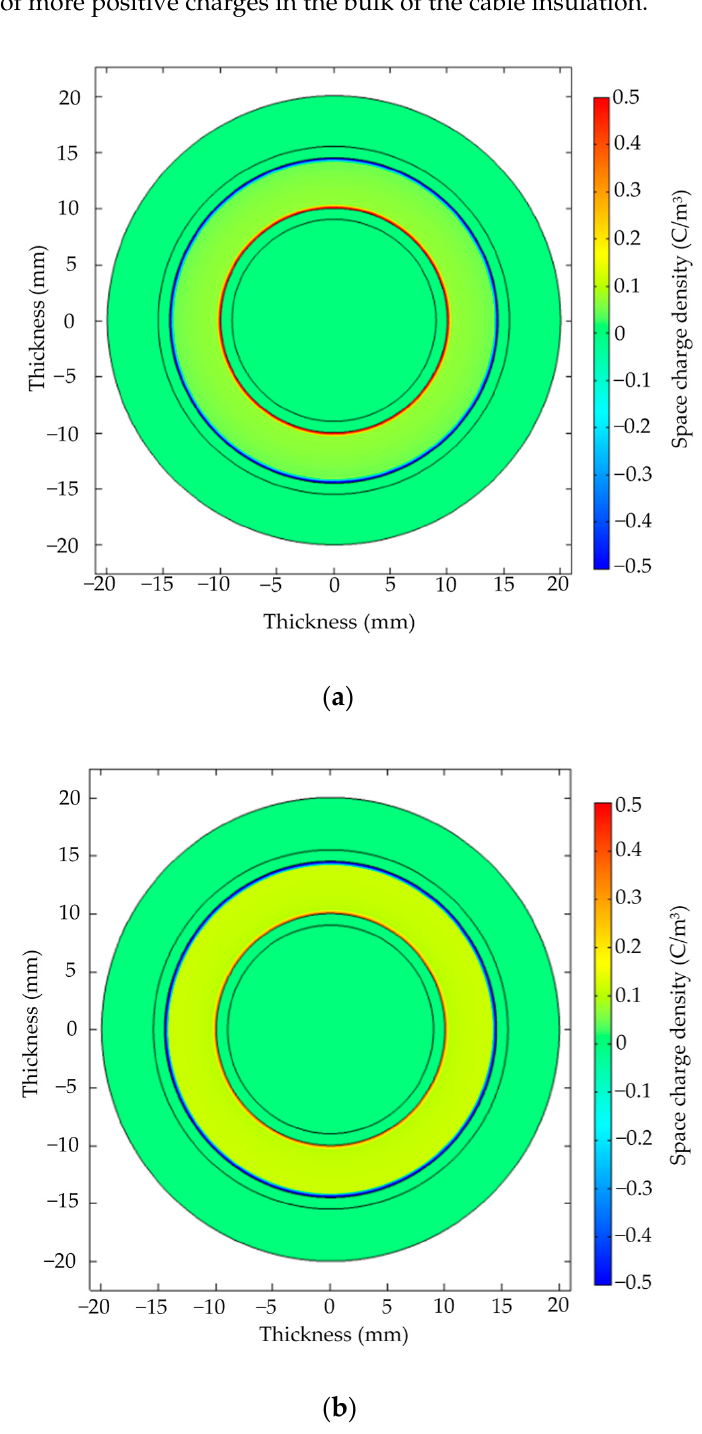
Figure 8. Simulation results at 5 h under the applied DC voltage of 67.5 kV: ( a ) insulation with the temperature difference of 15 °C; ( b ) insulation with the temperature difference of 30 °C.